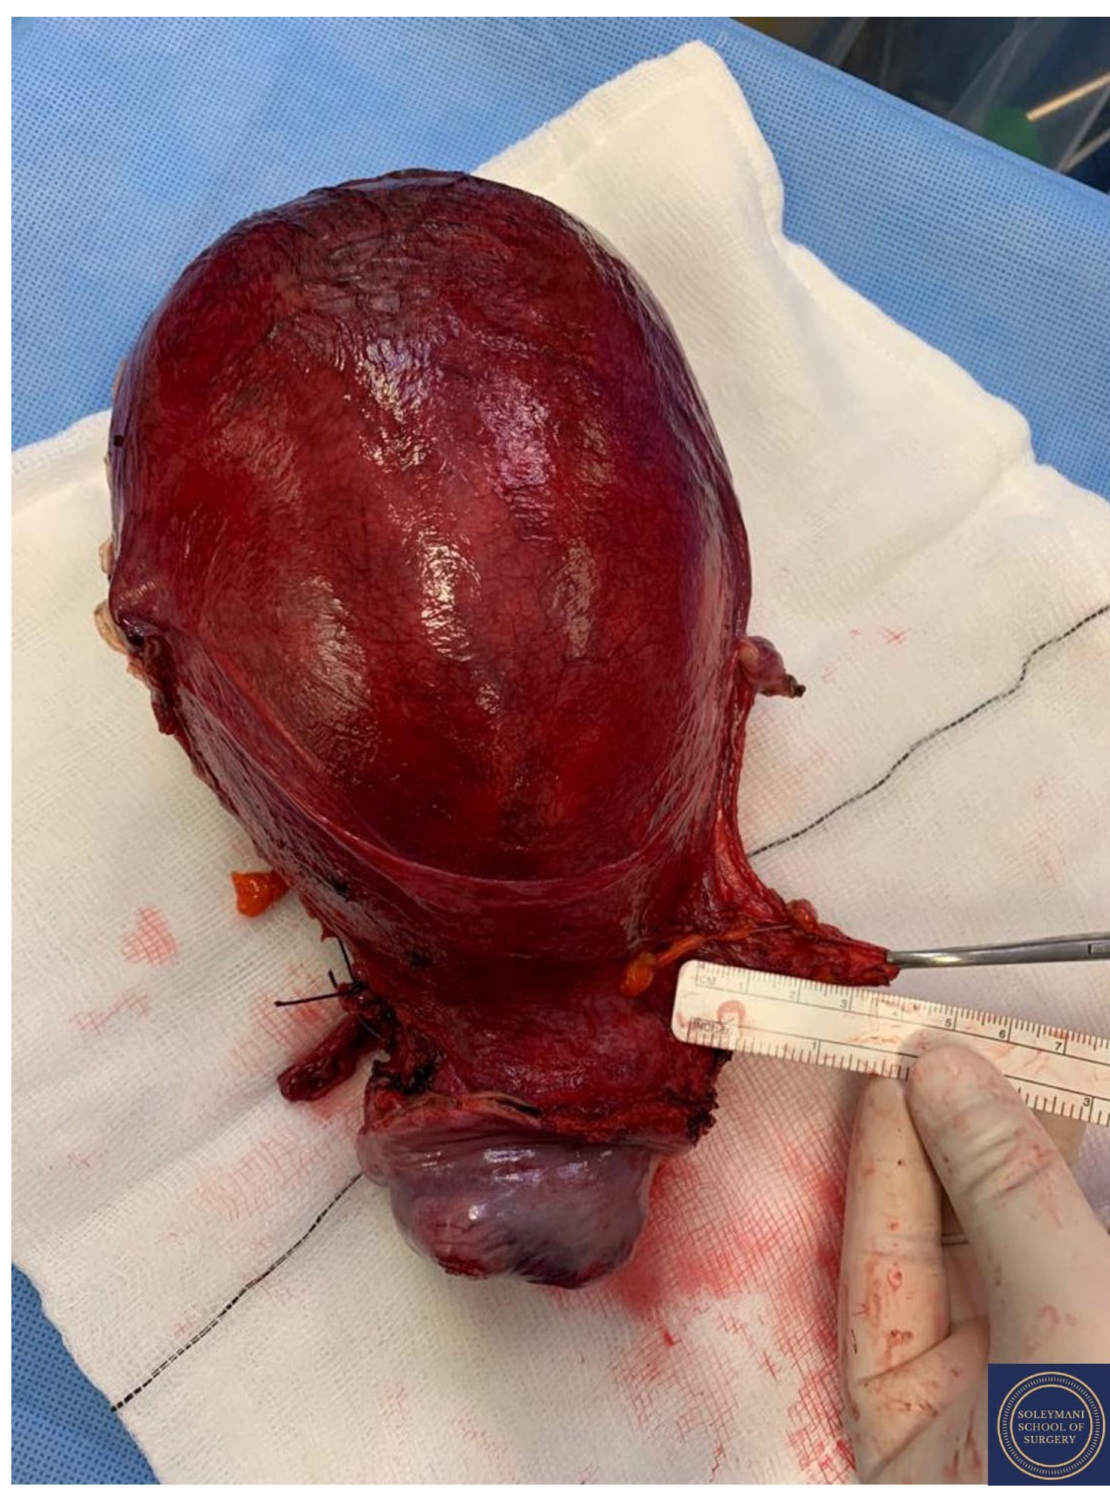
Figure 17. Appearance of the left parametrium and the corpus uteri prior to performance of hystero- tomy and delivery of the